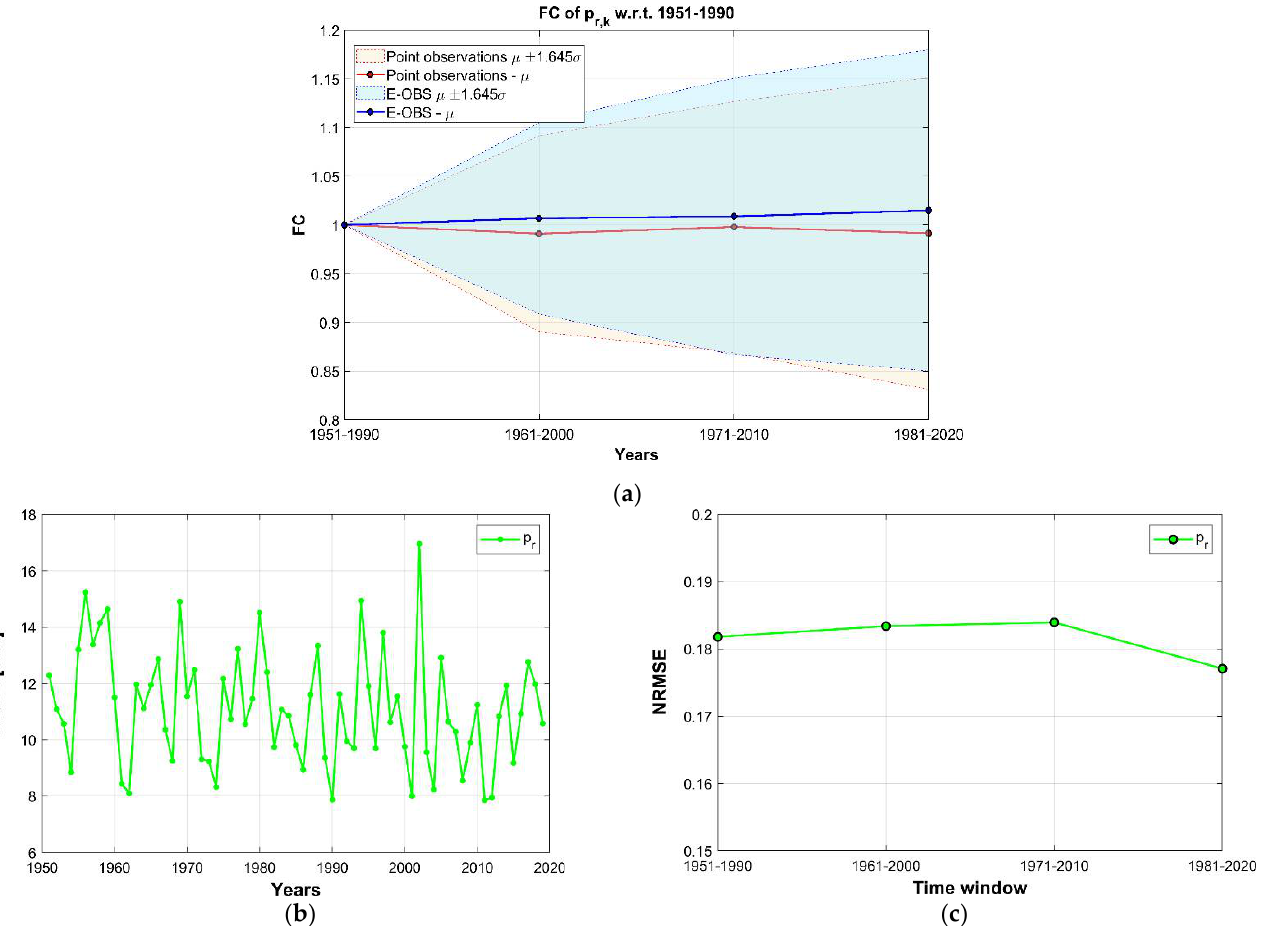
Figure 12. Factors of change for daily precipitation characterized by an annual probability of exceedance p = 0.02 ( a ), root-mean-square error (RMSE) values for annual maxima of daily precipitation ( b ) and normalized root-mean-square errors (NRMSE) between precipitation values characterized by an annual probability of exceedance p = 0.02, obtained by the E-OBS data, and recorded ones at test stations ( c ).